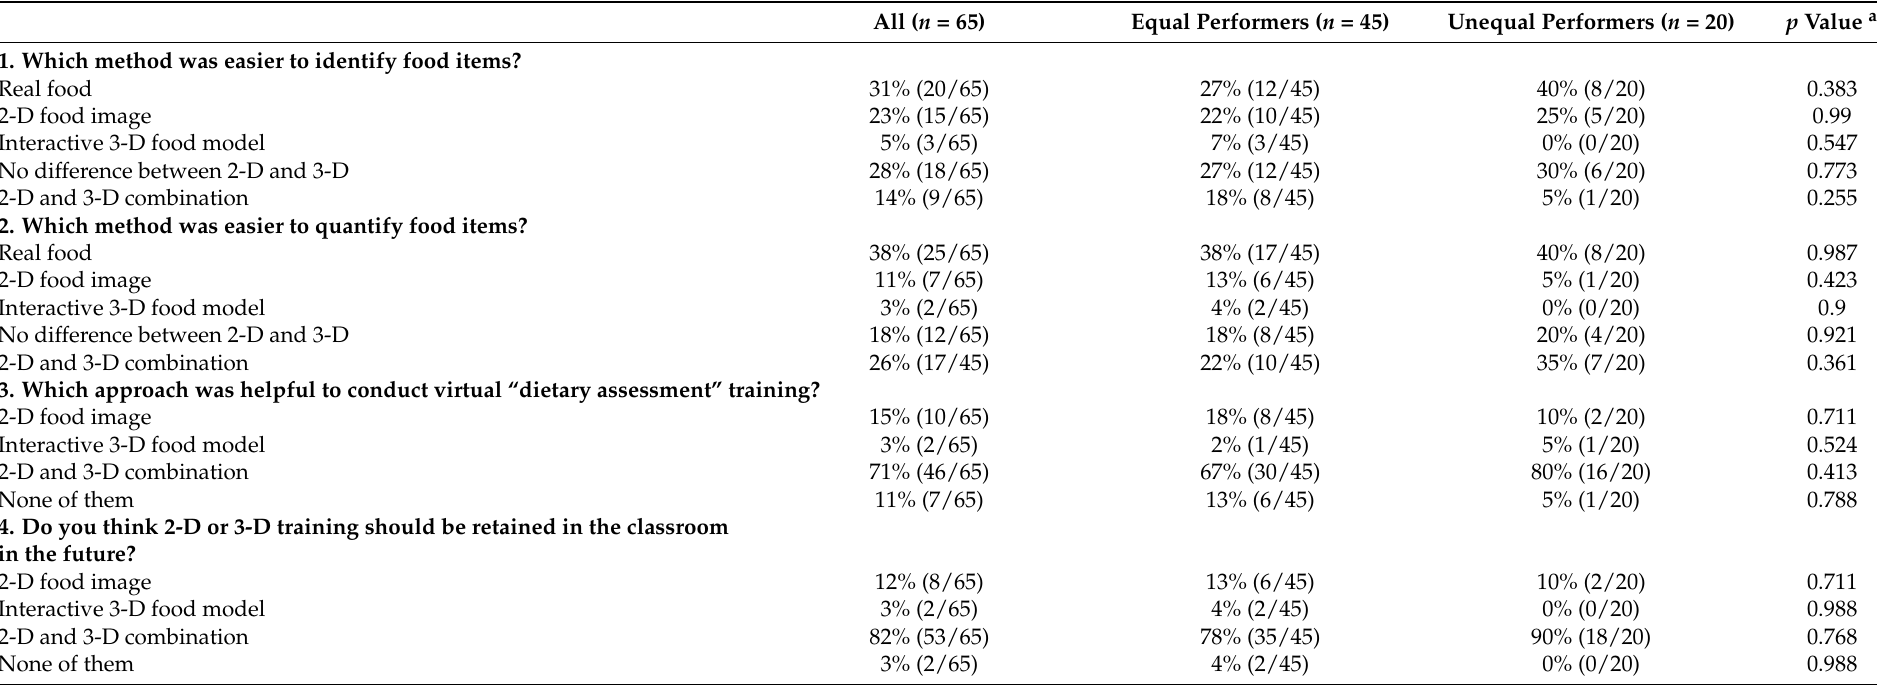
Table 2. Students’ receptiveness and responses to the educational integration of digital food models for portion size education ( n = 65). All ( n = 65) Equal Performers ( n = 45) Unequal Performers ( n = 20) p Value a